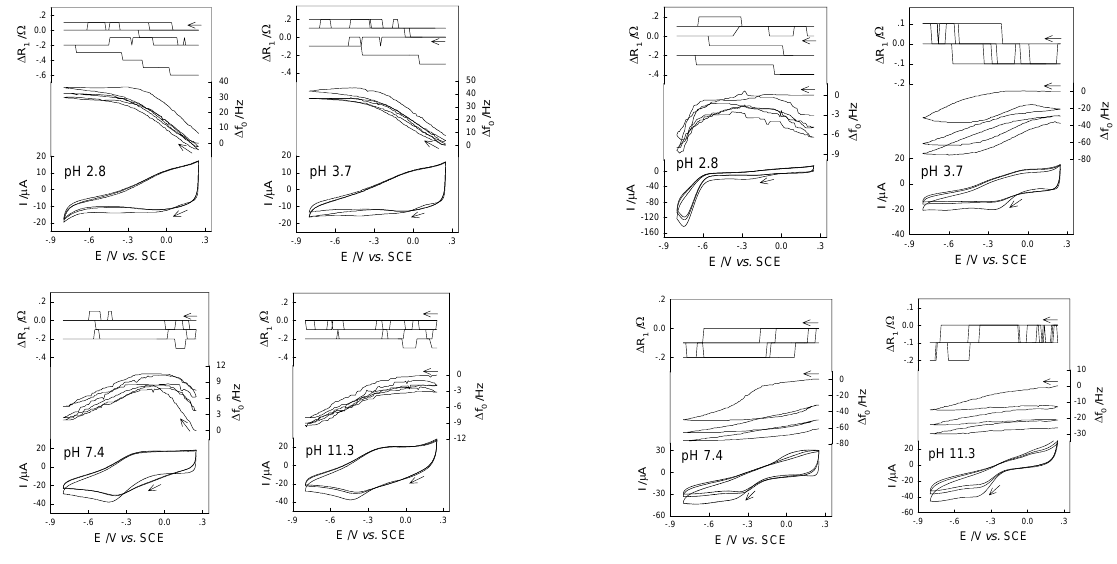
, and ∆ R during cyclic potential switching of a 0 1 aqueous solution whose pH values were adjusted by adding 4